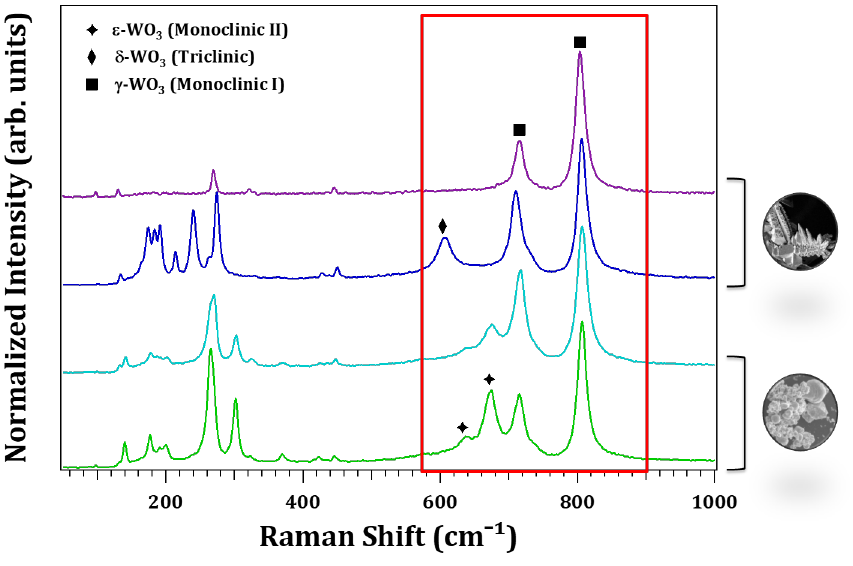
Figure 4. Comparison between Raman spectra from four representative samples in different structural states obtained on the surface of the W wire (purple and dark blue spectra) and on the Cu electrodes (green and blue